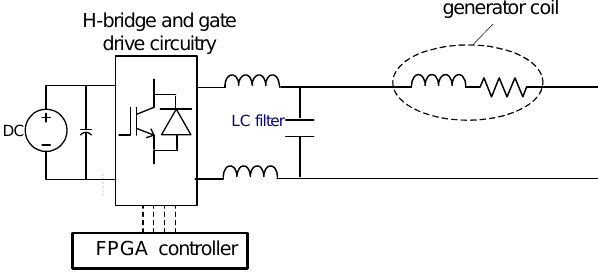
Figure 10. Wave Energy Emulator (1 phase).